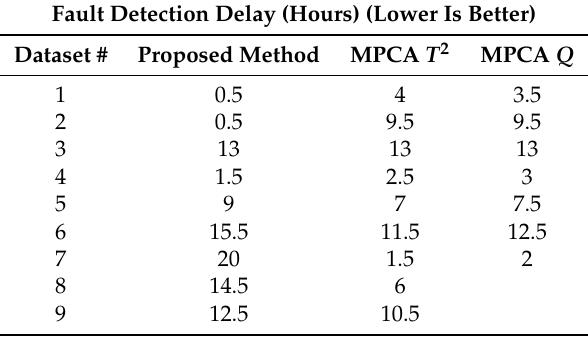
Table 7. Fault detection delay for the PenSim data. MPCA, multiway PCA. Fault Detection Delay (Hours) (Lower Is Better)